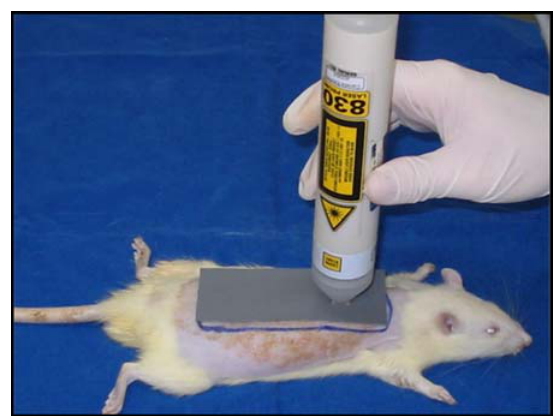
FIGURE 4 - Punctual contact technique